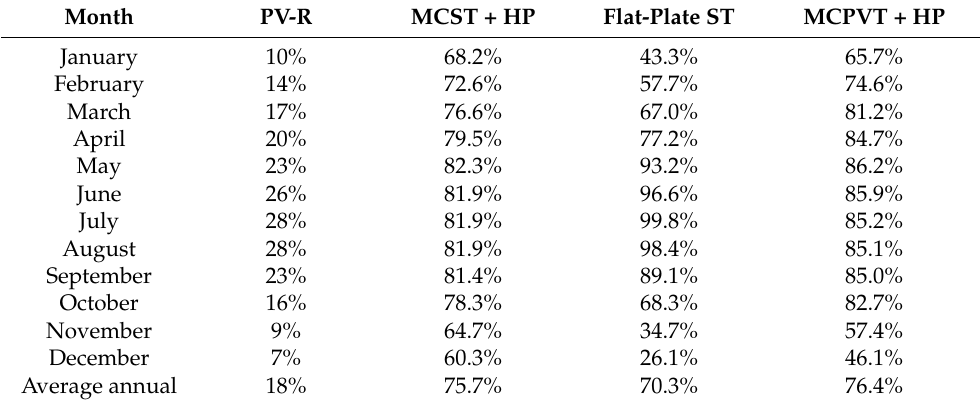
Table 13. Monthly solar fraction of four solar-based DHW systems for Toronto with 45-degree tilt